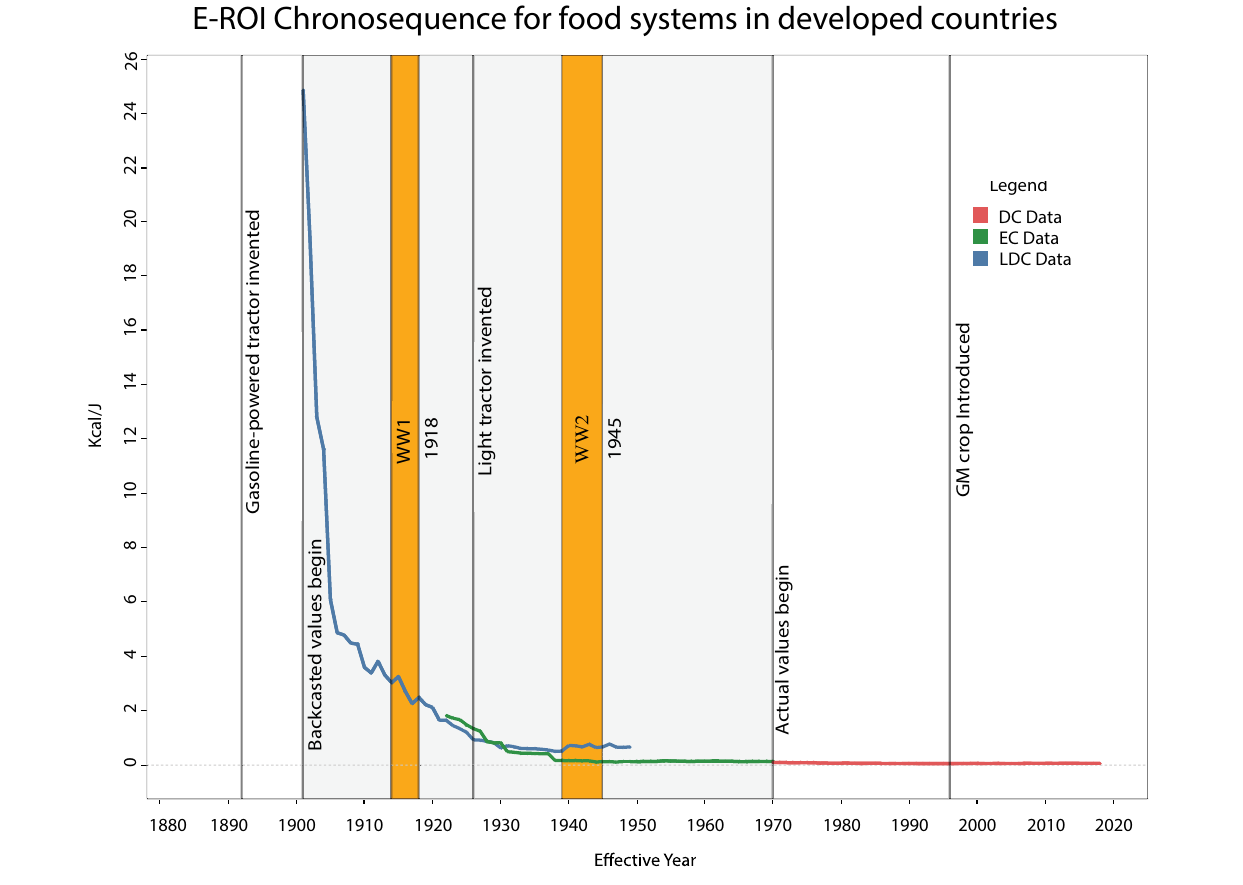
FIGURE 5 | A combined chronosequence of E-ROI data for Least Developed (LDC), Emerging (EC), and Developed (DC) countries offers a theoretical model for the complexification of DC food systems in the twentieth century, beginning with the introduction of mechanization and widespread irrigation, and then continuing through the addition of chemical inputs and industrial methods post-WW2. Data for DC represent actual values (beginning at 1970), whereas EC and LDC are year-adjusted to effectively back-cast the trend in DC using place-for-time substitution (see methods). We propose that DC food system transitions reached the point of over-complexification, where new investments in complexity began to be maladaptive, roughly around the end of